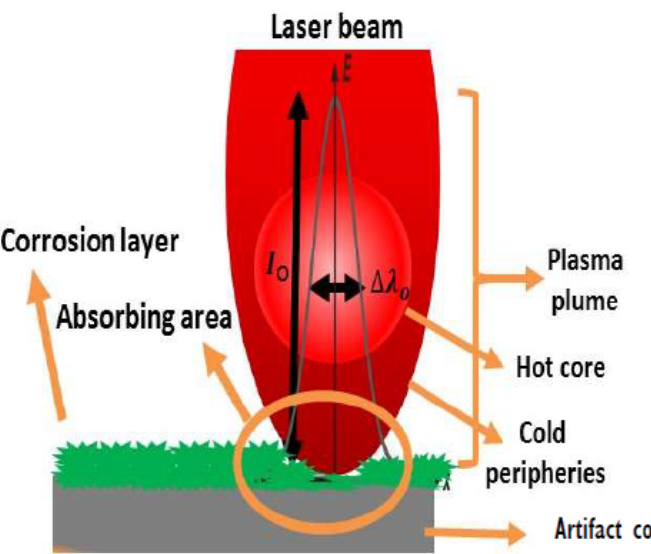
Figure 3. Laser-cleaning model for coin sample-based metal artifacts.